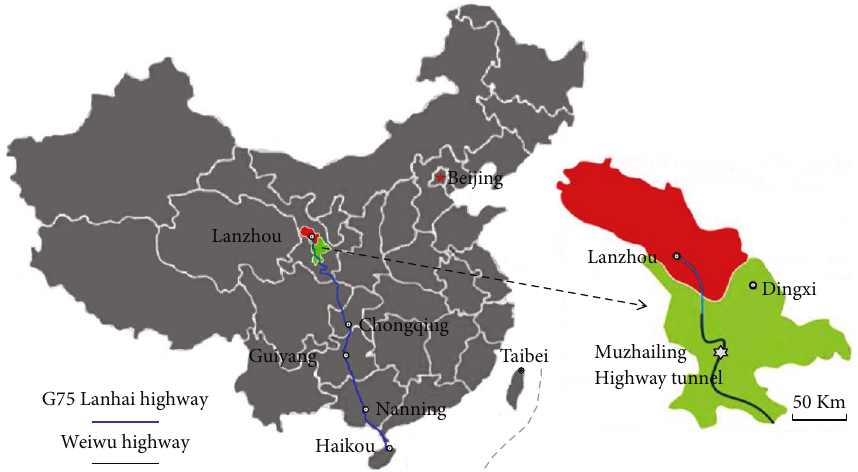
Figure 1: The location of Muzhailing highway tunnel.